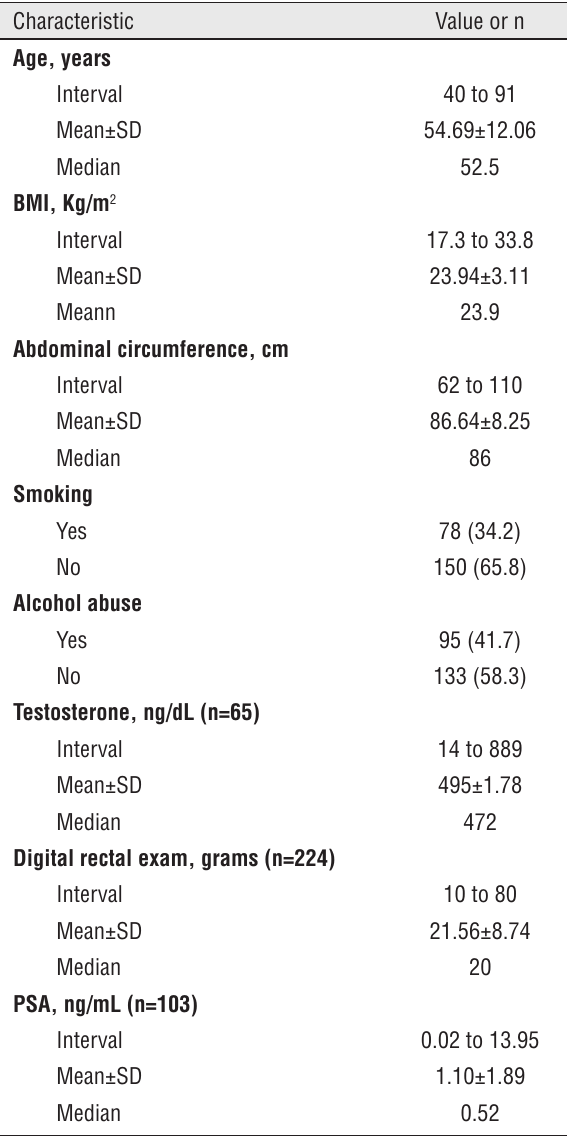
Table 1 - Clinical and laboratory characteristics of Indians